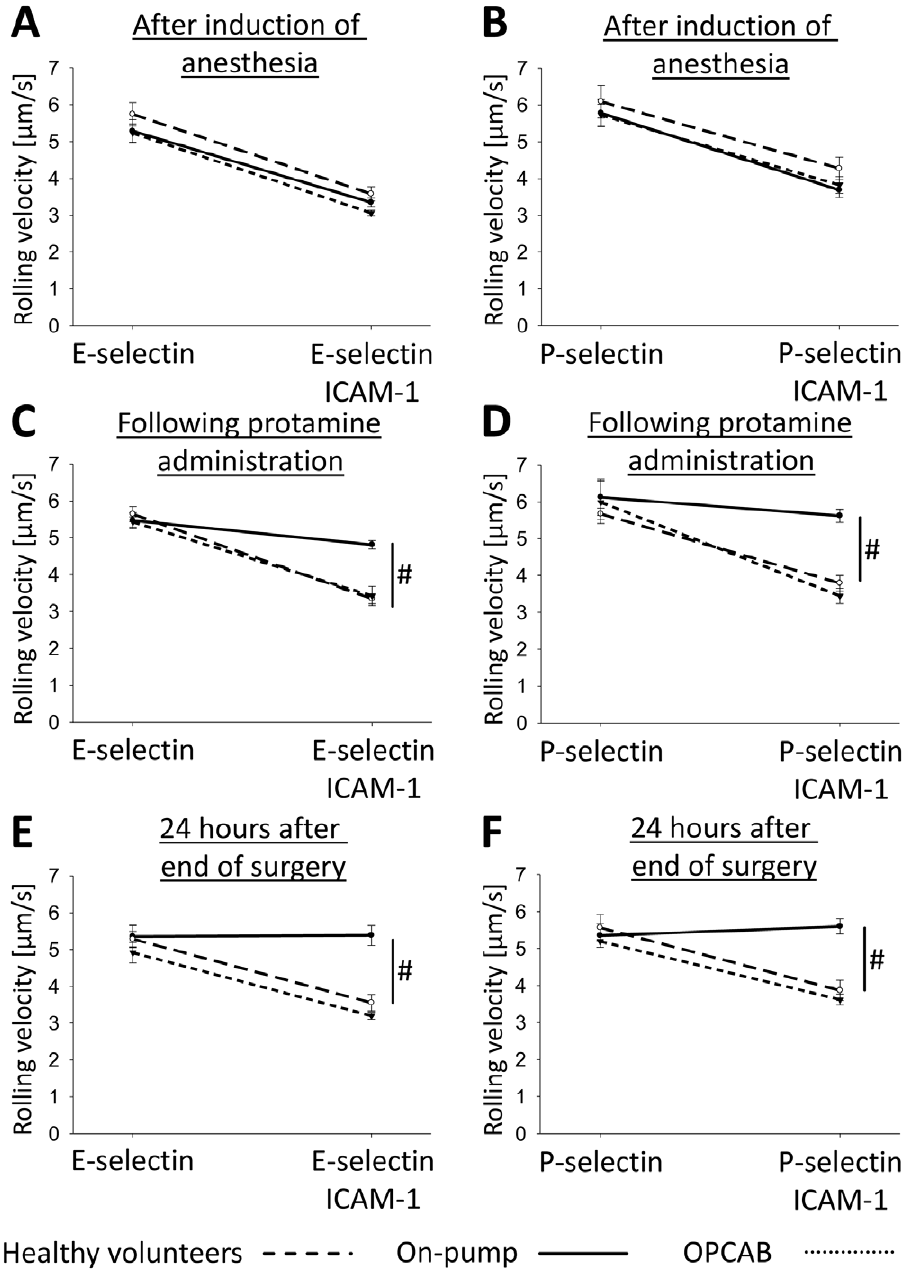
Figure 1. Selectin-mediated slow leukocyte rolling is abolished in patients after CPB. The rolling velocity of neutrophils in whole blood from healthy control volunteers (dashed line), on-pump patients (straight line) and OPCAB patients (dotted line) was measured after induction of anesthesia (A, B), following administration of protamine (C, D), and 24 hours after the end of surgery (E, F) using microflow chambers coated with E- selectin or P-selectin alone and in combination with ICAM-1. The average rolling velocity of neutrophils is presented as mean 6 SEM (n=7–9). The wall shear stress in all flow chamber experiments was 5–6 dynes/cm 2 . # p , 0.05.